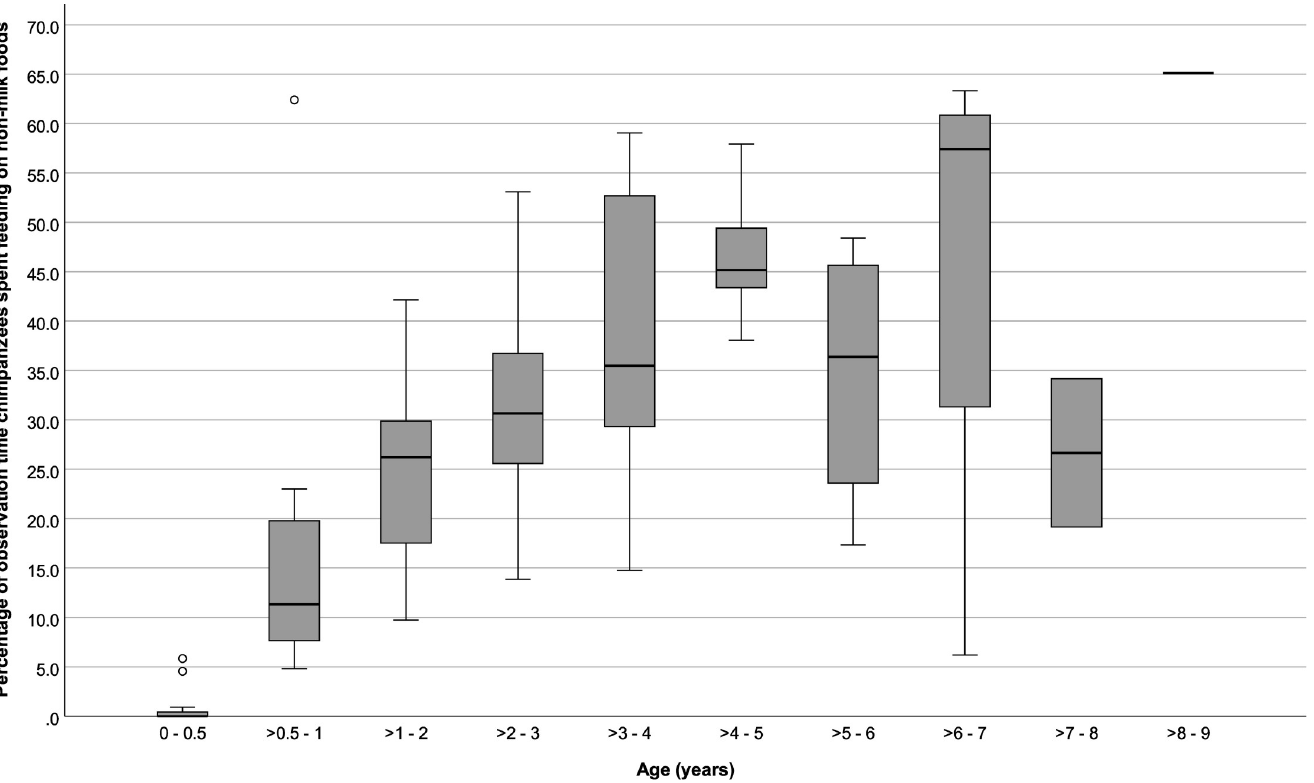
Fig 4. Percentage of focal observation time that immature chimpanzees spent foraging at different ages. Box plots show median values (solid horizontal lines), 25th and 75th percentile values (box boundaries), highest and lowest values (whiskers) and outliers (circles).